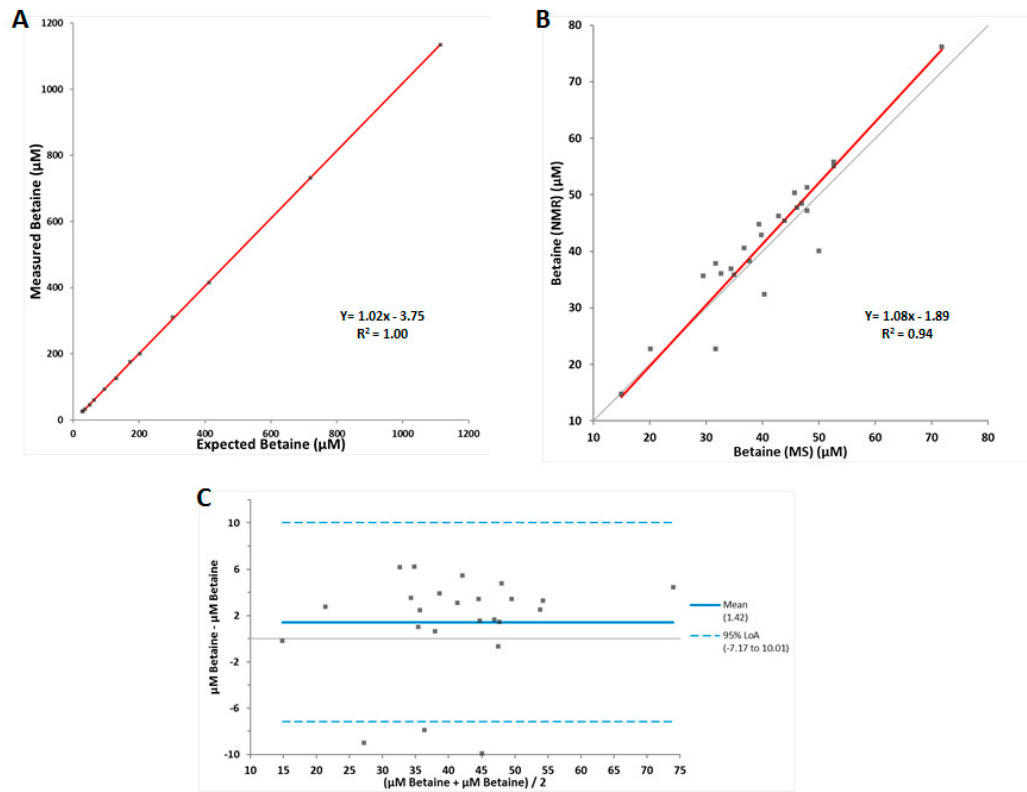
Figure 2. Linearity and method comparison data for the betaine assay. (A ) Results of linearity study ( n = 13), ( B ) Deming regression comparison between LC-MS/MS and NMR measured betaine in serum samples ( n = 24), ( C ) Bland–Altman plot ( n = 24). The limits of agreement (LoA) are depicted as dotted blue lines, and the 0% bias is a solid black line.